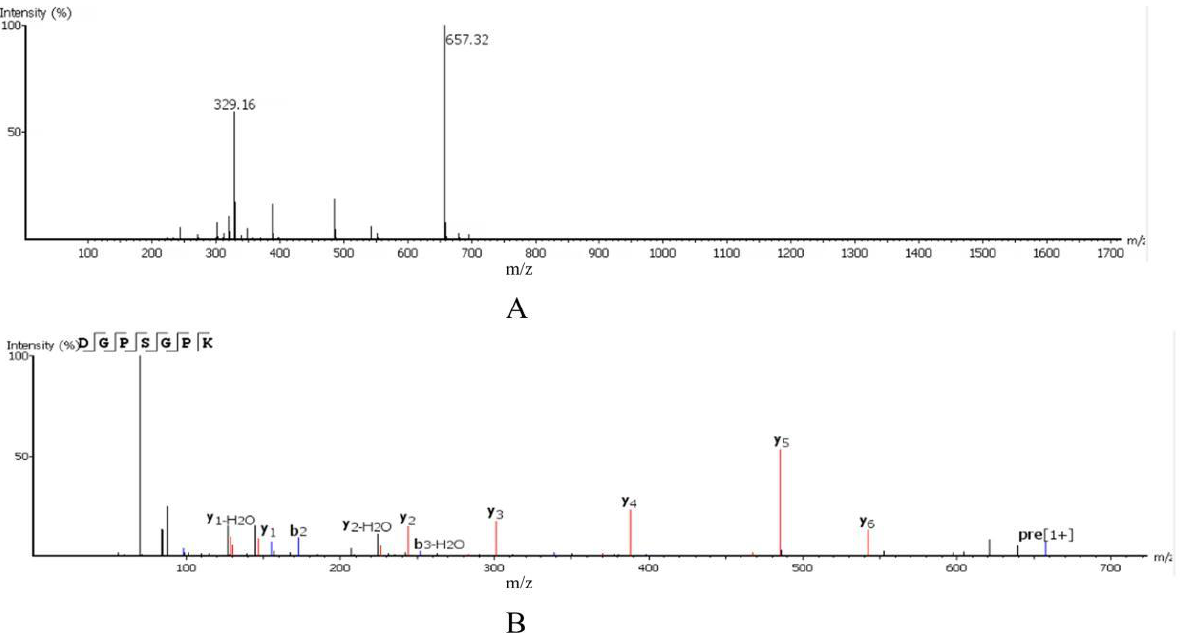
Figure 3. MS/MS spectrum of DGPSGPK. ( A ) Primary mass spectrum; ( B ) secondary mass spectrum.